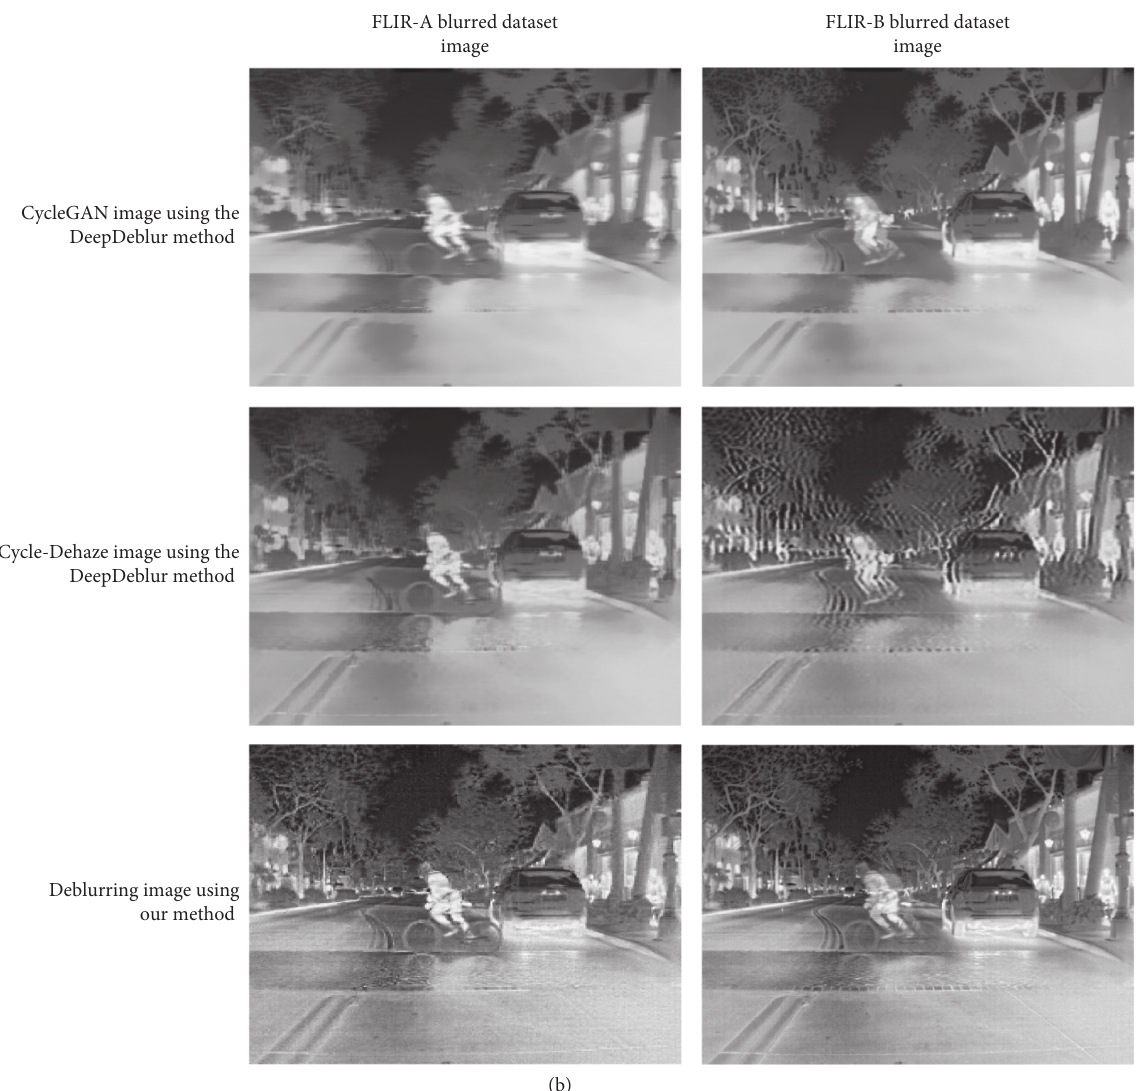
Figure 7: Comparison of deblurring results between FLIR-A and FLIR-B blurred datasets.